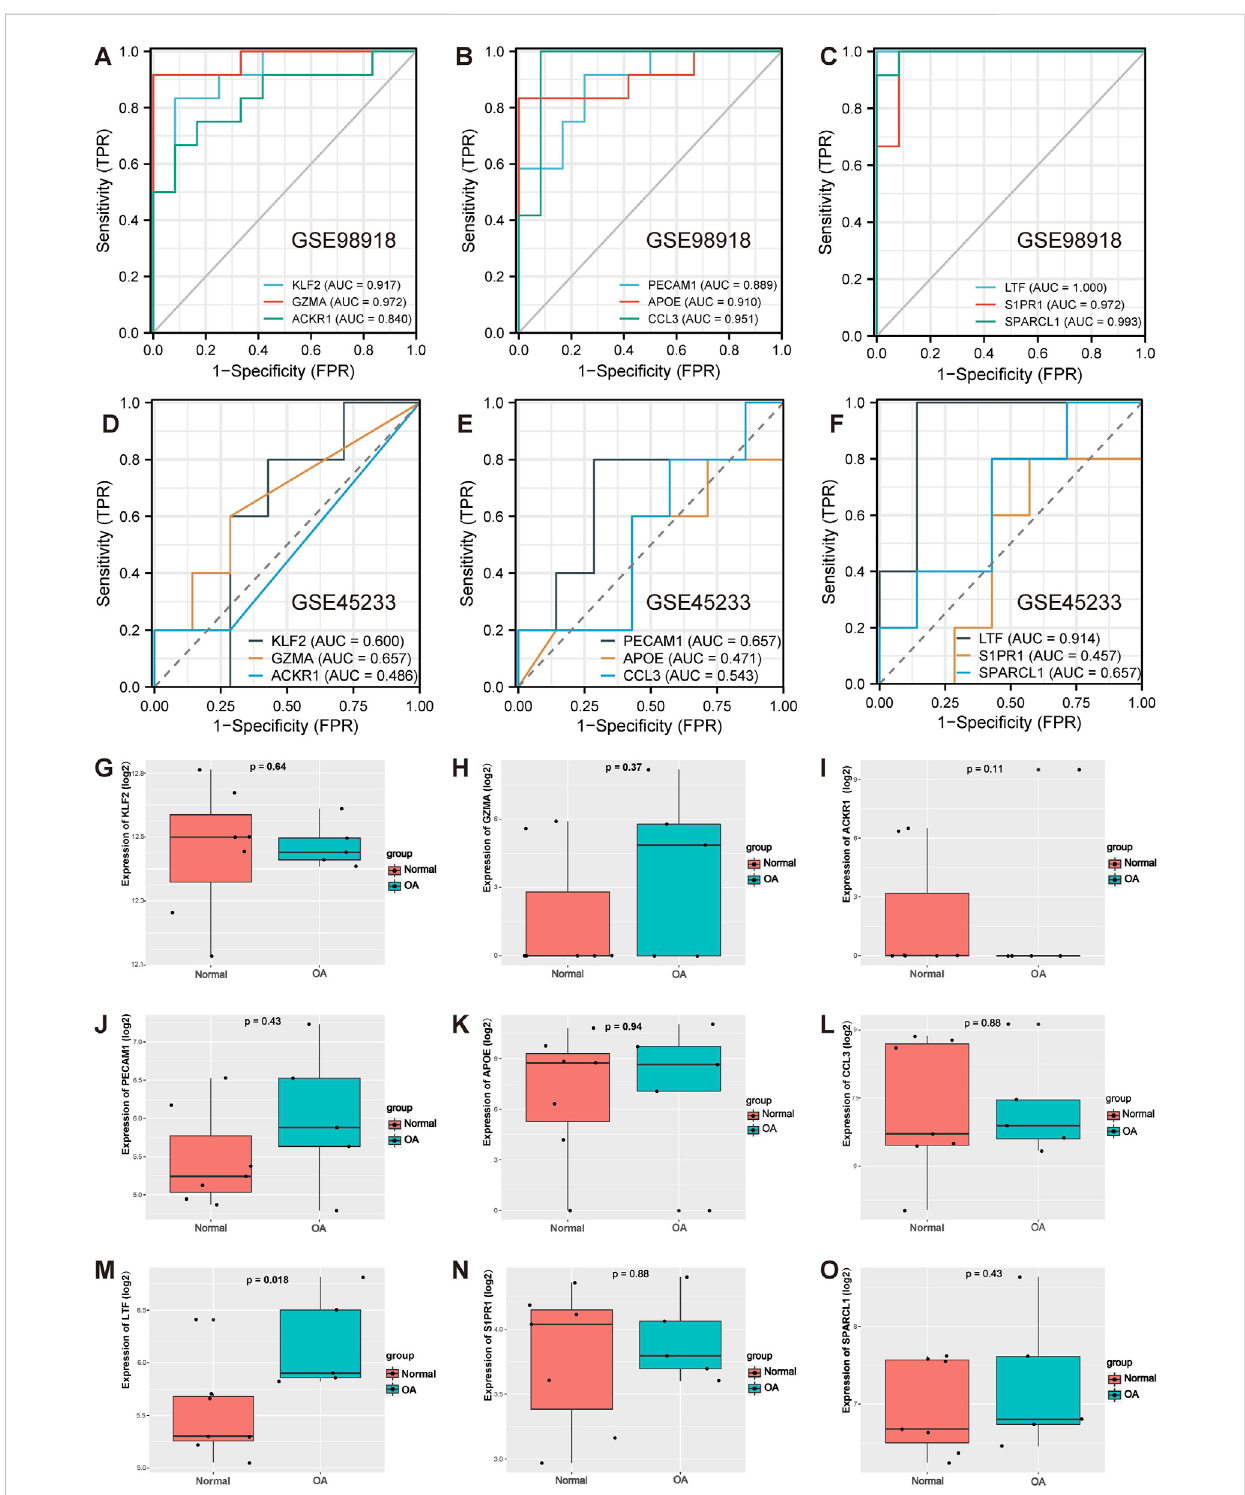
FIGURE 4 ROC curve analysis of hub genes in the GSE98918 dataset and validation of hub genes in the GSE45233 dataset. (A) ROC curve analysis of KLF2, GZMA, ACKR1 in the GSE98918 dataset. (B) ROC curve analysis of PECAM1, APOE, CCL3 in the GSE98918 dataset. (C) ROC curve analysis of LTF, S1PR1, SPARCL1 in the GSE98918 dataset. (D) ROC curve analysis of KLF2, GZMA, ACKR1 in the GSE45233 dataset. (E) ROC curve analysis of PECAM1, APOE, CCL3 in the GSE45233 dataset. (F) ROC curve analysis of LTF, S1PR1, SPARCL1 in the GSE45233 dataset. (G) The expression of KLF2 in the GSE45233 dataset. (H) The expression of GZMA in the GSE45233 dataset (I) The expression of ACKR1 in the GSE45233 dataset (J) The expression of PECAM1 in the GSE45233 dataset (K) The expression of APOE in the GSE45233 dataset. ( L ) The expression of CCL3 in the GSE45233 dataset. ( M )